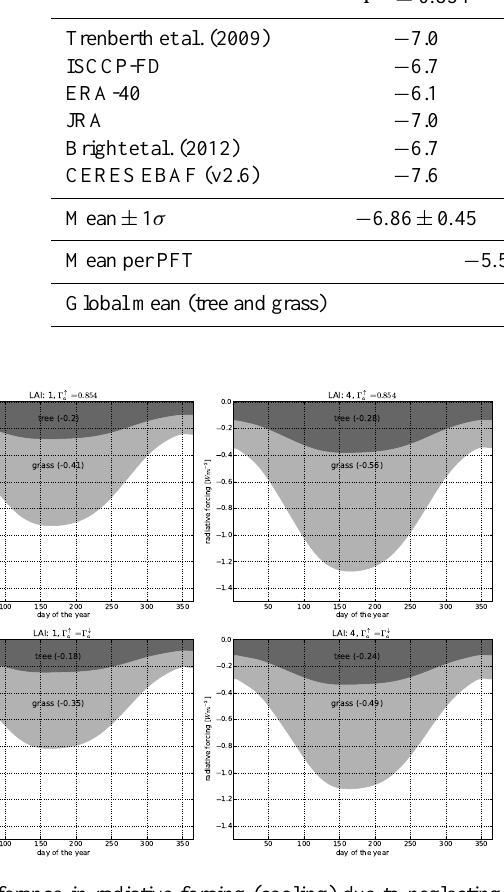
Fig. 7. Difference in radiative forcing (cooling) due to neglecting Fig.7. Differenceinradiativeforcing(cooling)duetoneglectingthediurnalcycleforsurfacealbedoschemesforglobaltreeandgrasscover and different leaf area (columns). Different rows correspond to different parameterizations of the shortwave upward one-way atmospheric the diurnal cycle for surface albedo schemes for global tree and transmissivity( Γ ↑ ).Valuesinparenthesescorrespondtoglobalmeanvalues. grass cover and different leaf areas (columns). Different rows corre- spond to different parameterizations of the shortwave upward one- tualshadowingorthescatteringbetweenmultiplecanopyel- ements. way atmospheric transmissivity ( 0 ↑ ). Values in parentheses corre- spond to global mean